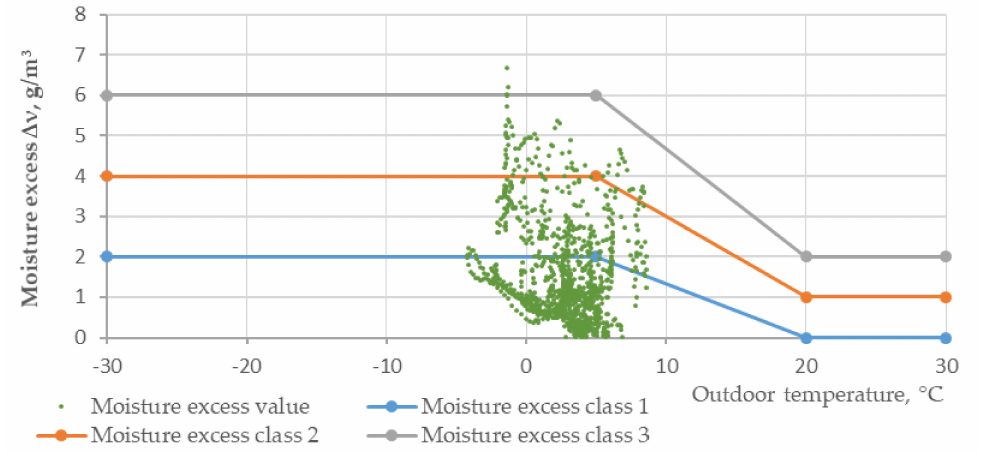
Figure 5. Calculated hourly values of moisture excess in the test apartment from 7 February 2020 to 29 March 2020. Reproduced with permission from